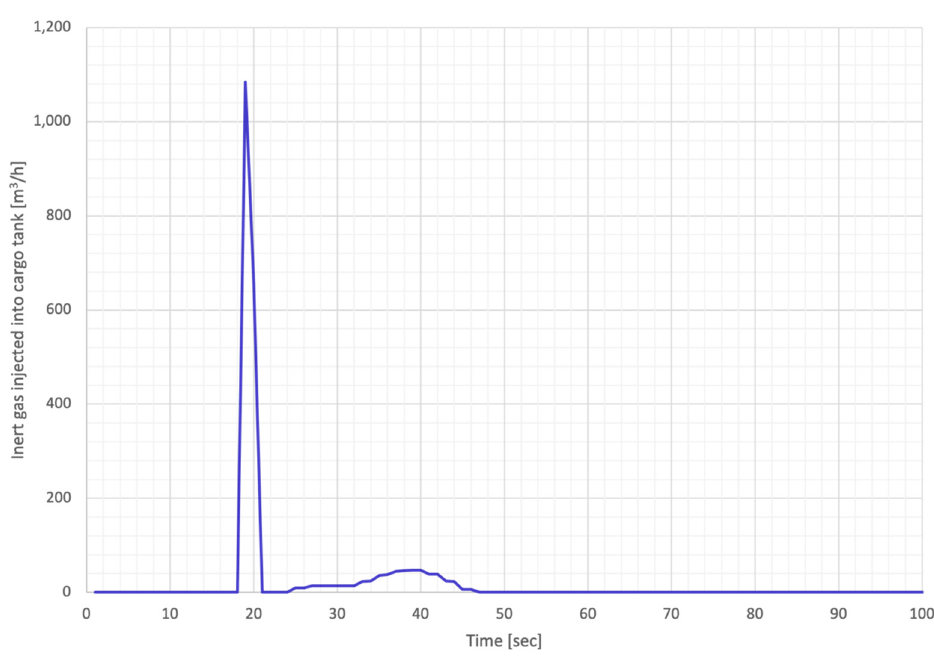
Figure 15. Tank discharge pressure.